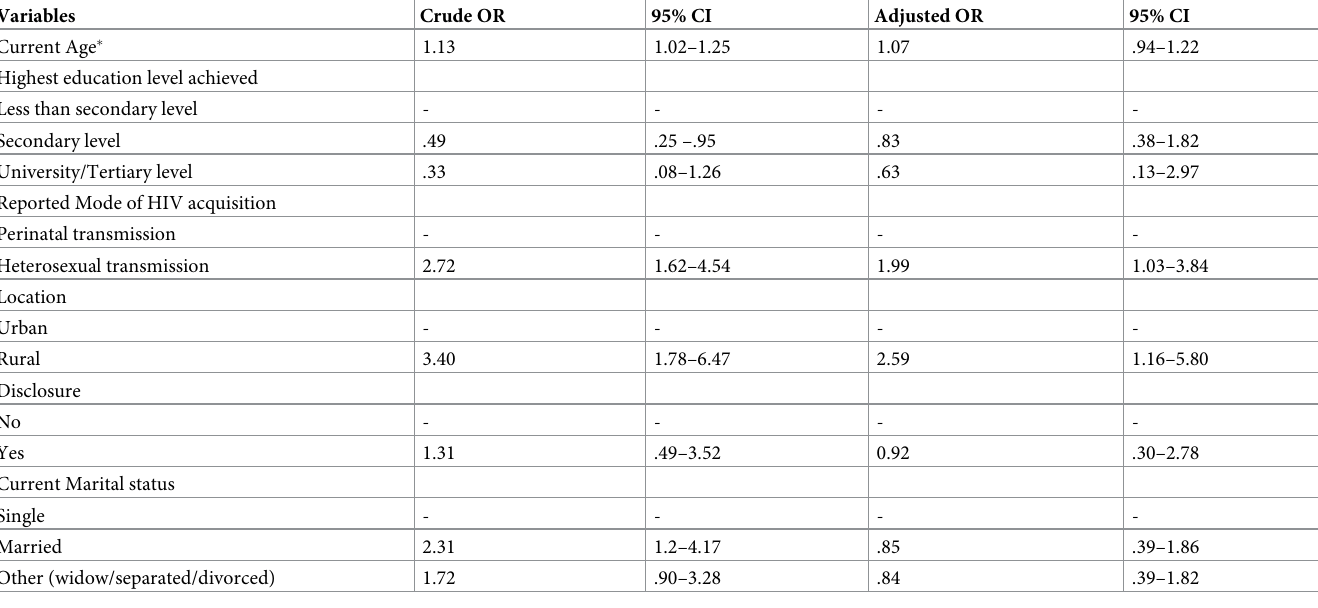
Table 3. Factors associated with reported ART adherence (never missing an ARV